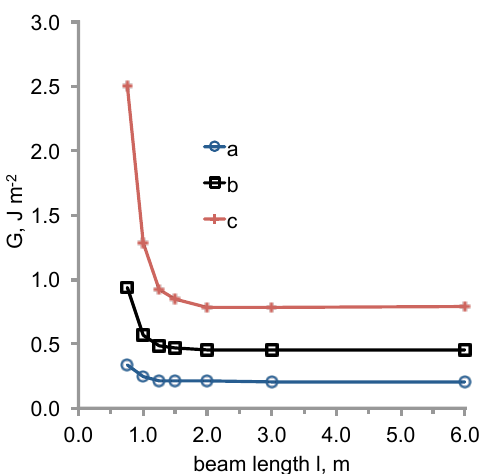
Figure 9. Energy release rate G vs. beam length l . G is plotted for test lengths l = 0 . 75–6.00m for each of the profiles (a, b, c) in Fig. 8. For each profile, the crack length is r c , the measured critical length from 1.4–1.5m long field tests (Sect. 2.1).